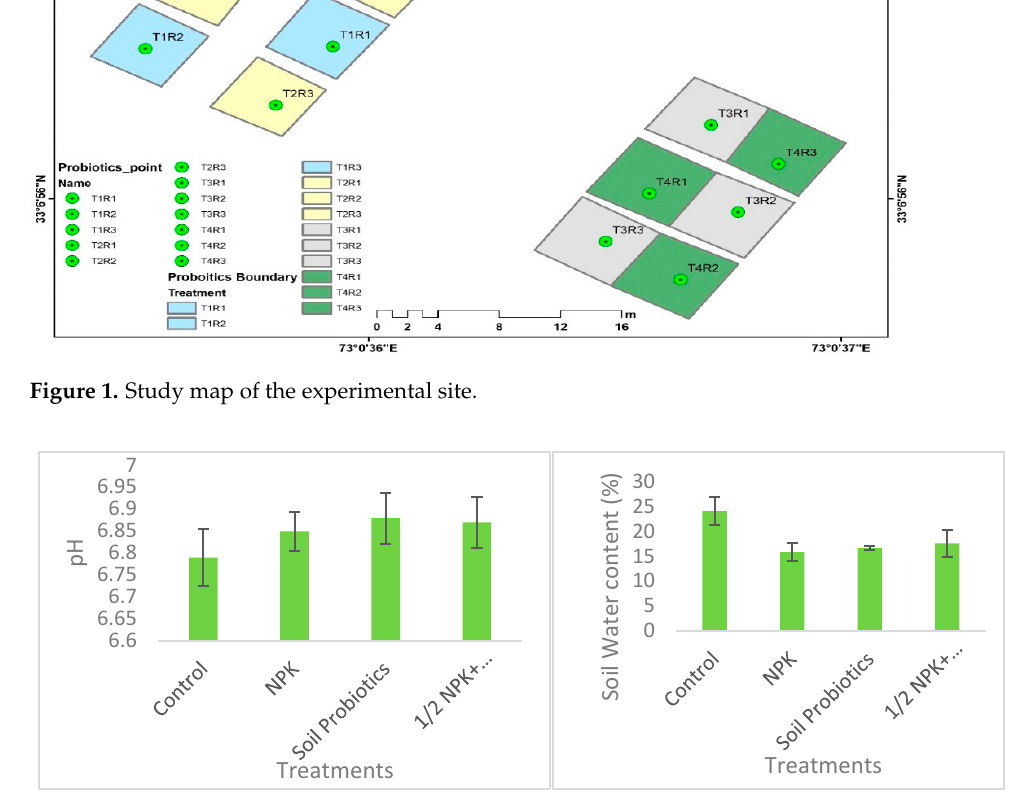
Figure 2. pH and moisture of the experimental site.